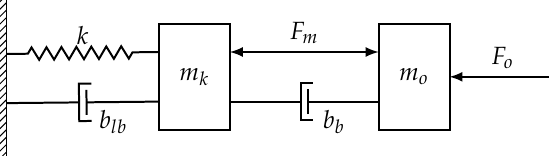
Figure 2. Simplified models of FSEA ( a ) and RFSEA ( b ).